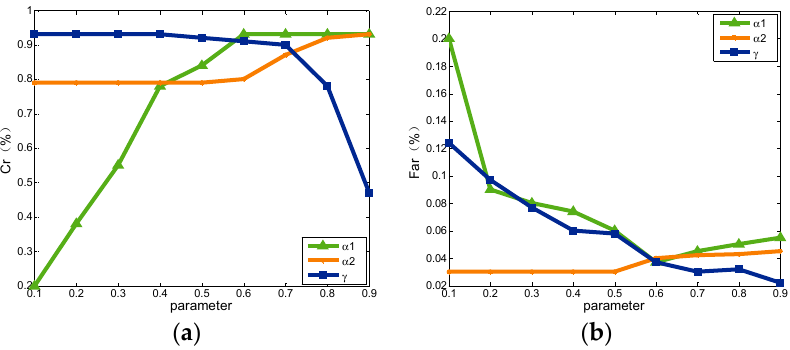
Figure 16. Cr and Far curves for different relaxation parameters: ( a ) Cr curves; ( b ) Far curves.